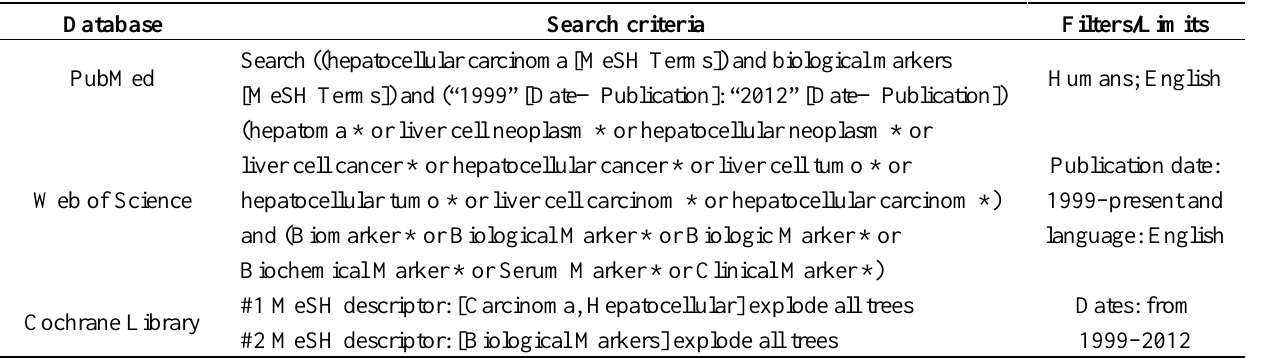
Figure 1. Literature screening was performed at four levels. Level 1, reviews, letters, case reports, editorials, and comments were excluded from the papers identified using the above search strategy. Level 2, articles in which biomarkers were not evaluated for their utility in detecting hepatocellular carcinoma (HCC) were excluded. The full texts of reports that